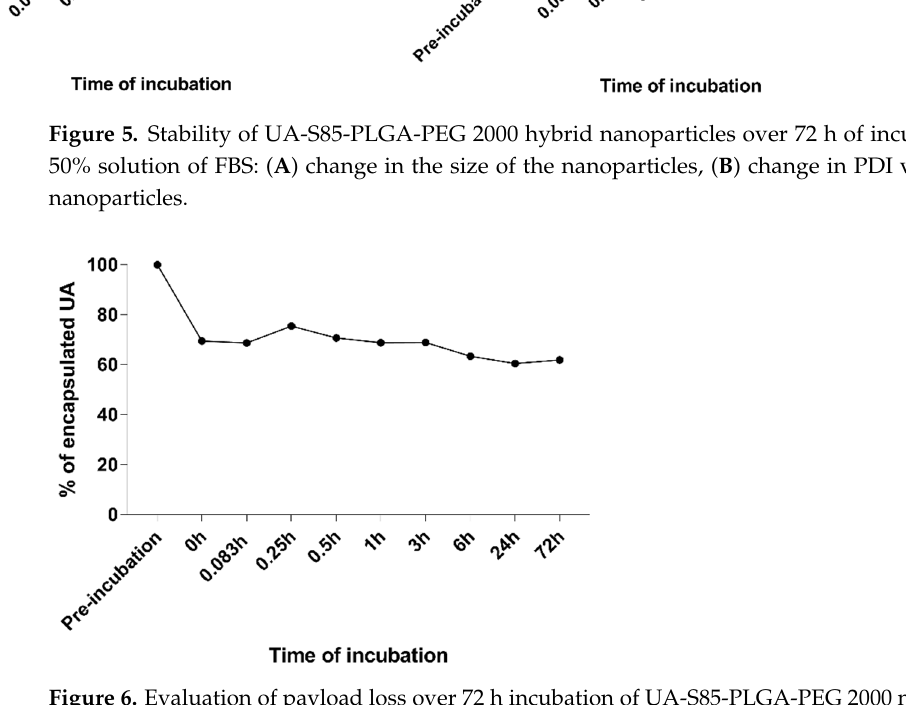
Figure 6. Evaluation of payload loss over 72 h incubation of UA-S85-PLGA-PEG 2000 nanoparticles with 50% FBS.